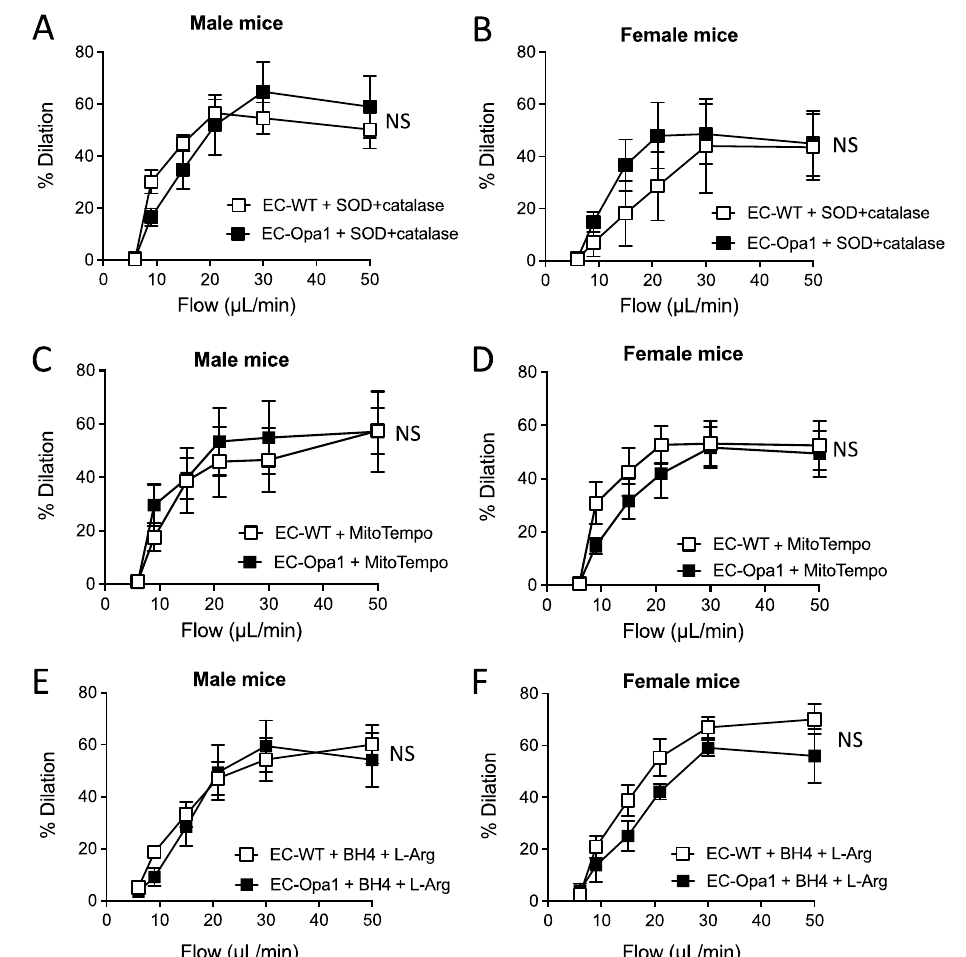
Figure 5. Consequence of reducing oxidative stress on flow-mediated dilation. Flow-mediated dilation was measured in mesenteric resistance arteries isolated from EC-WT and EC-Opa1 male and female mice after a treatment with SOD (120 U/mL, 30 min) plus catalase (80 U/mL, min) ( A , B ), MitoTempo (1 µ mol/L, 30 min, 5 C , D ), or tetrahydrobiopterin (BH4, 10 µ mol/L, 30 min) plus L-arginine (L-Arg, 100 µ mol/L, 30 min) ( E , F ). Means ± SEM are shown (n = 5 mice per group). NS: Two-way ANOVA for repeated measurements .